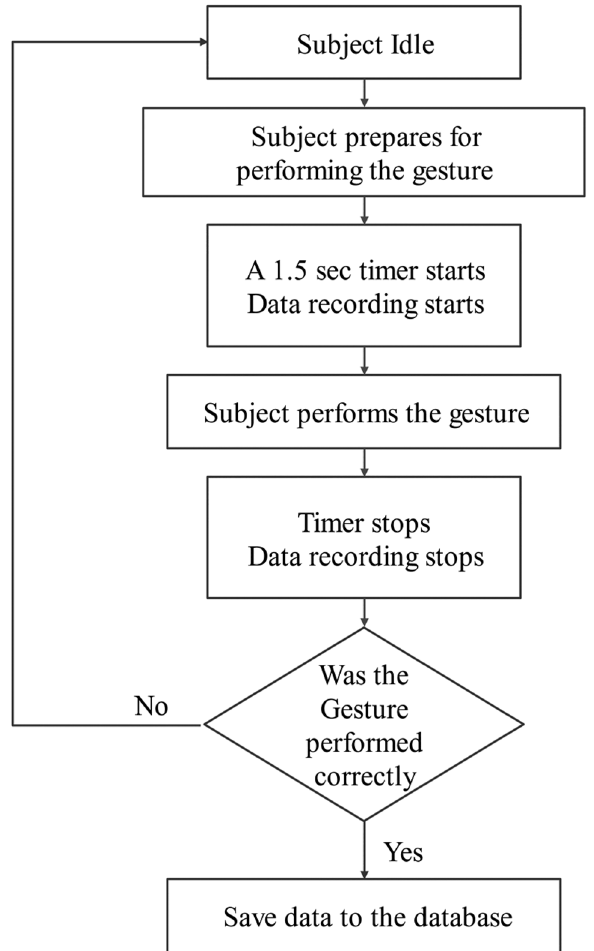
Figure 2. The flowchart showing the data collection protocol. The diagram shows all the different steps of the data collection process. This protocol was followed during the data collection for all the